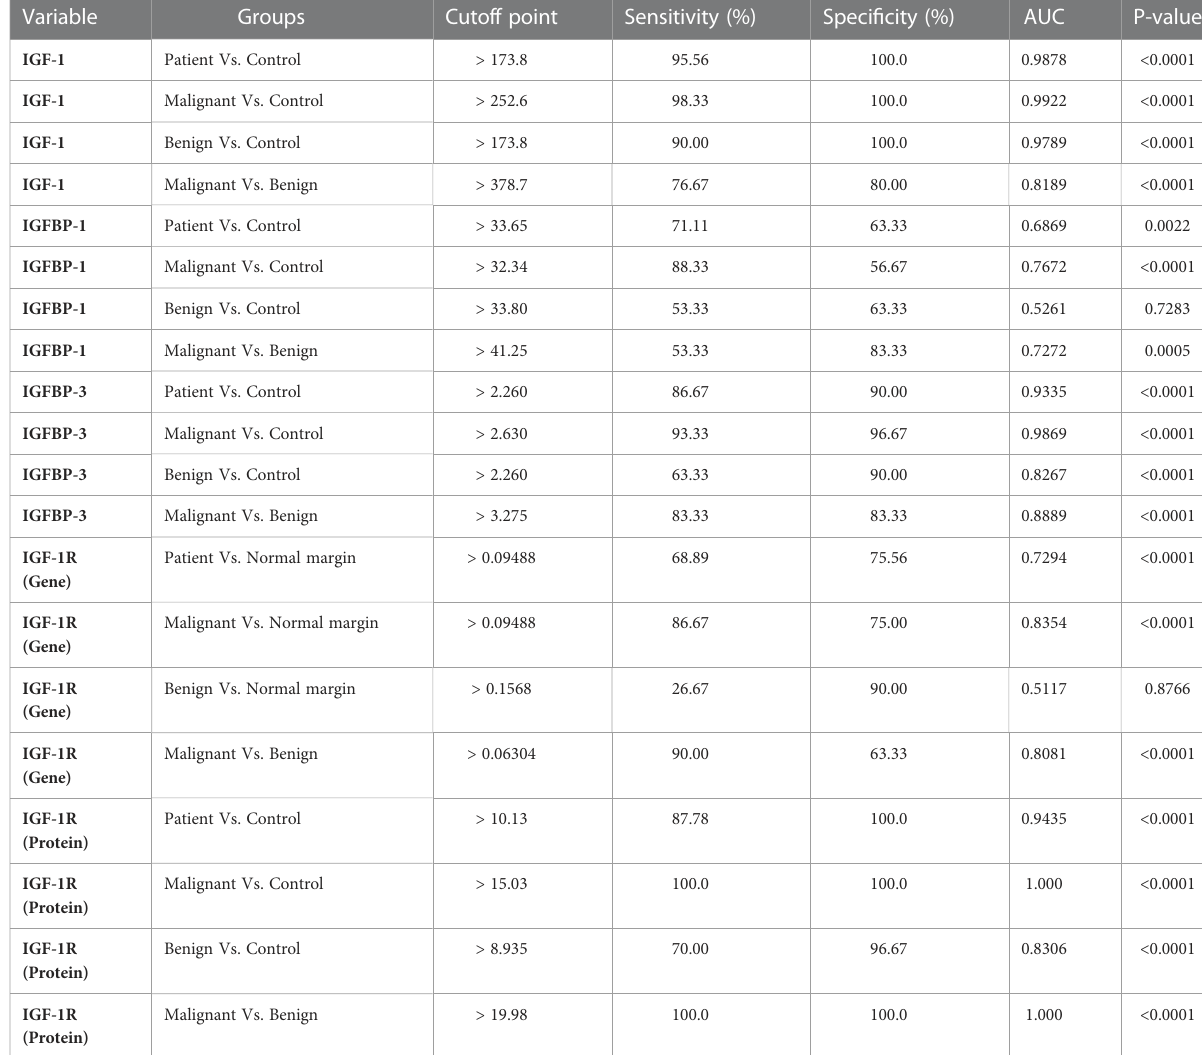
TABLE 1 The value of IGF axis to discriminate between different groups of primary bone tumors (ROC curve information).